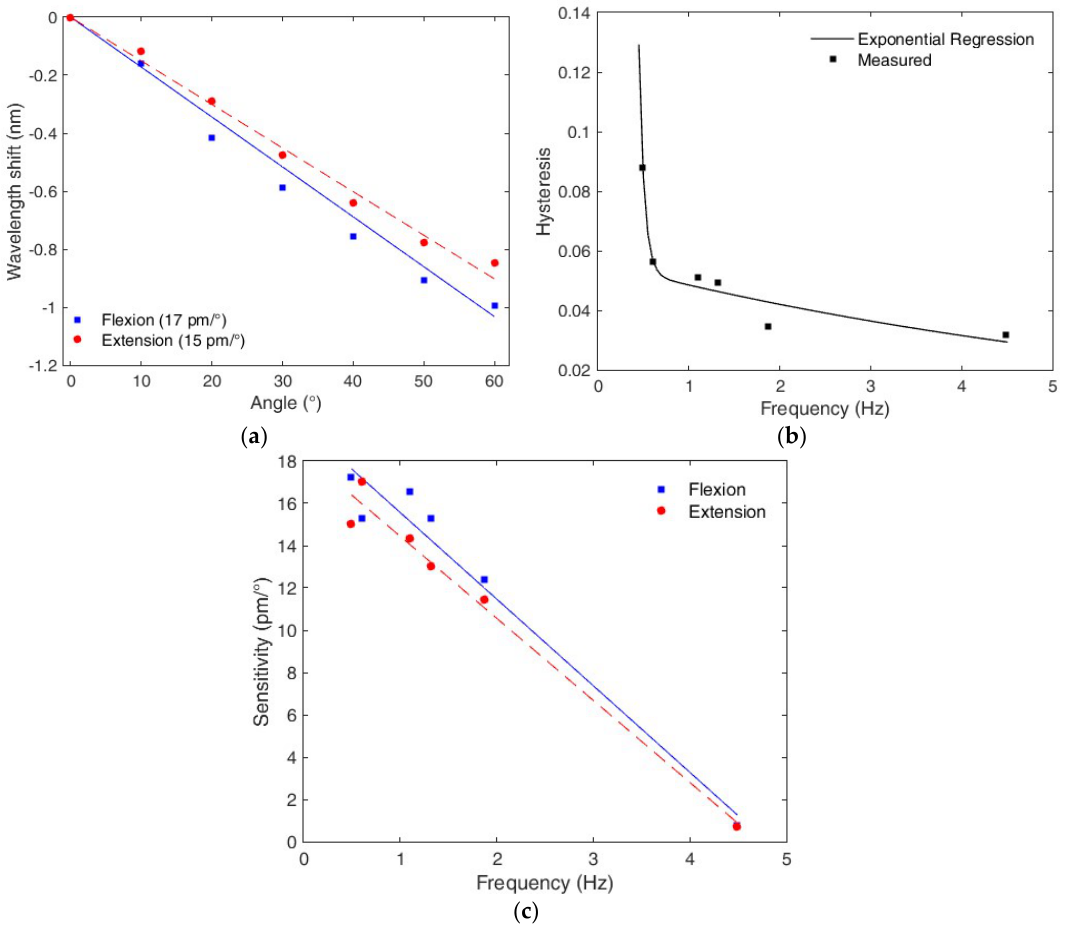
Figure 8. ( a ) Flexion and extension cycles at 0.5 Hz with the sensitivity of each cycle. ( b ) Hysteresis variation as a function of the frequency. ( c ) Sensitivity difference between flexion and extension cycles at each frequency.